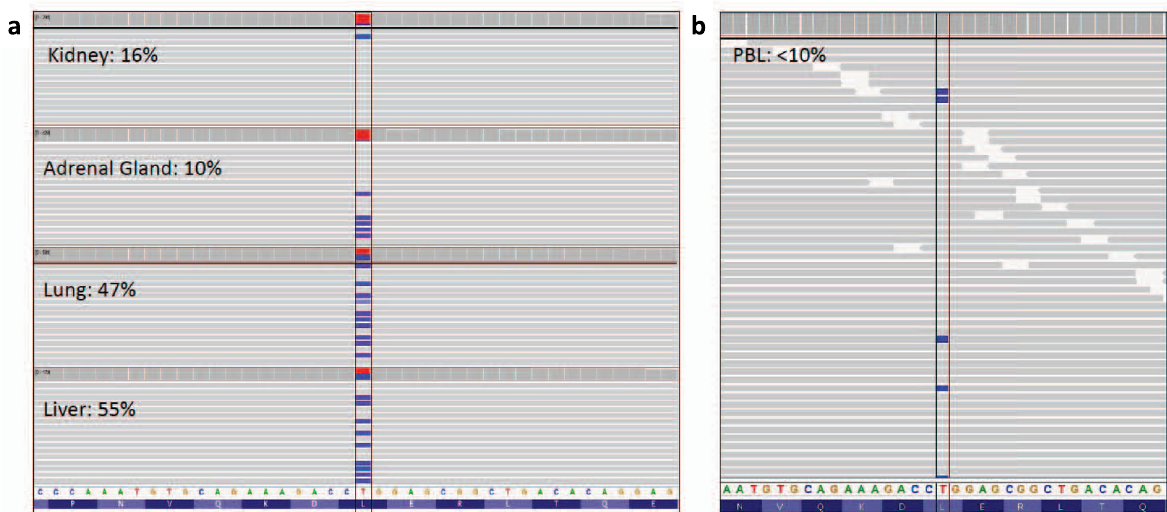
Fig. 2 Visualization of VHL variant in tumor and germline DNA. Integrative Genomics Viewer display of the c.593 T > C (p.Leu198Pro) variant in tissue from four tumor specimens ( a ) and peripheral blood leukocytes ( b ). The percentage of sequencing reads (gray bars) depicting the variant are beside the biospecimen type. The blue bars depict a cytosine nucleotide instead of a thymine nucleotide at the variant loci. The overall proportion of cytosine:thymine reads is represented by the blue:red bars at the top of each tissue panel. Tumor cellularity was estimated by a pathologist to be 65% in the kidney tissue and 85% in the adrenal gland, lung, and liver